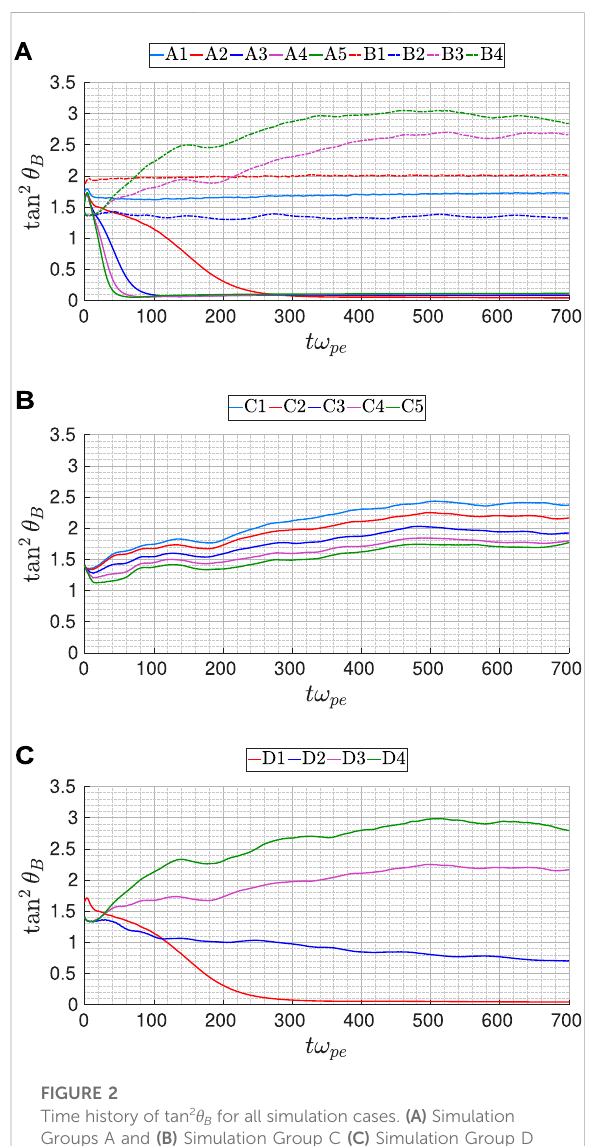
FIGURE 2 Time history of tan 2 θ B for all simulation cases. (A) Simulation Groups A and (B) Simulation Group C (C) Simulation Group